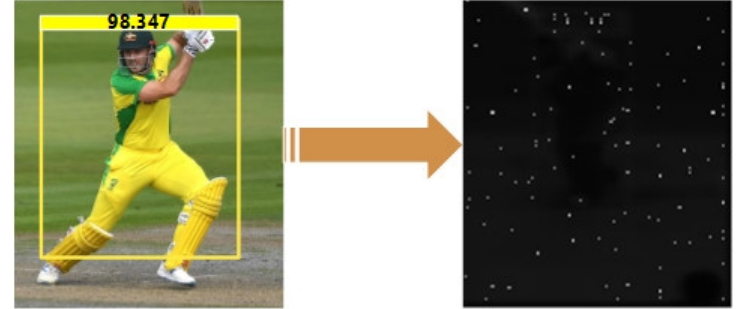
Figure 7. Extracted SIFT features of the detected person.